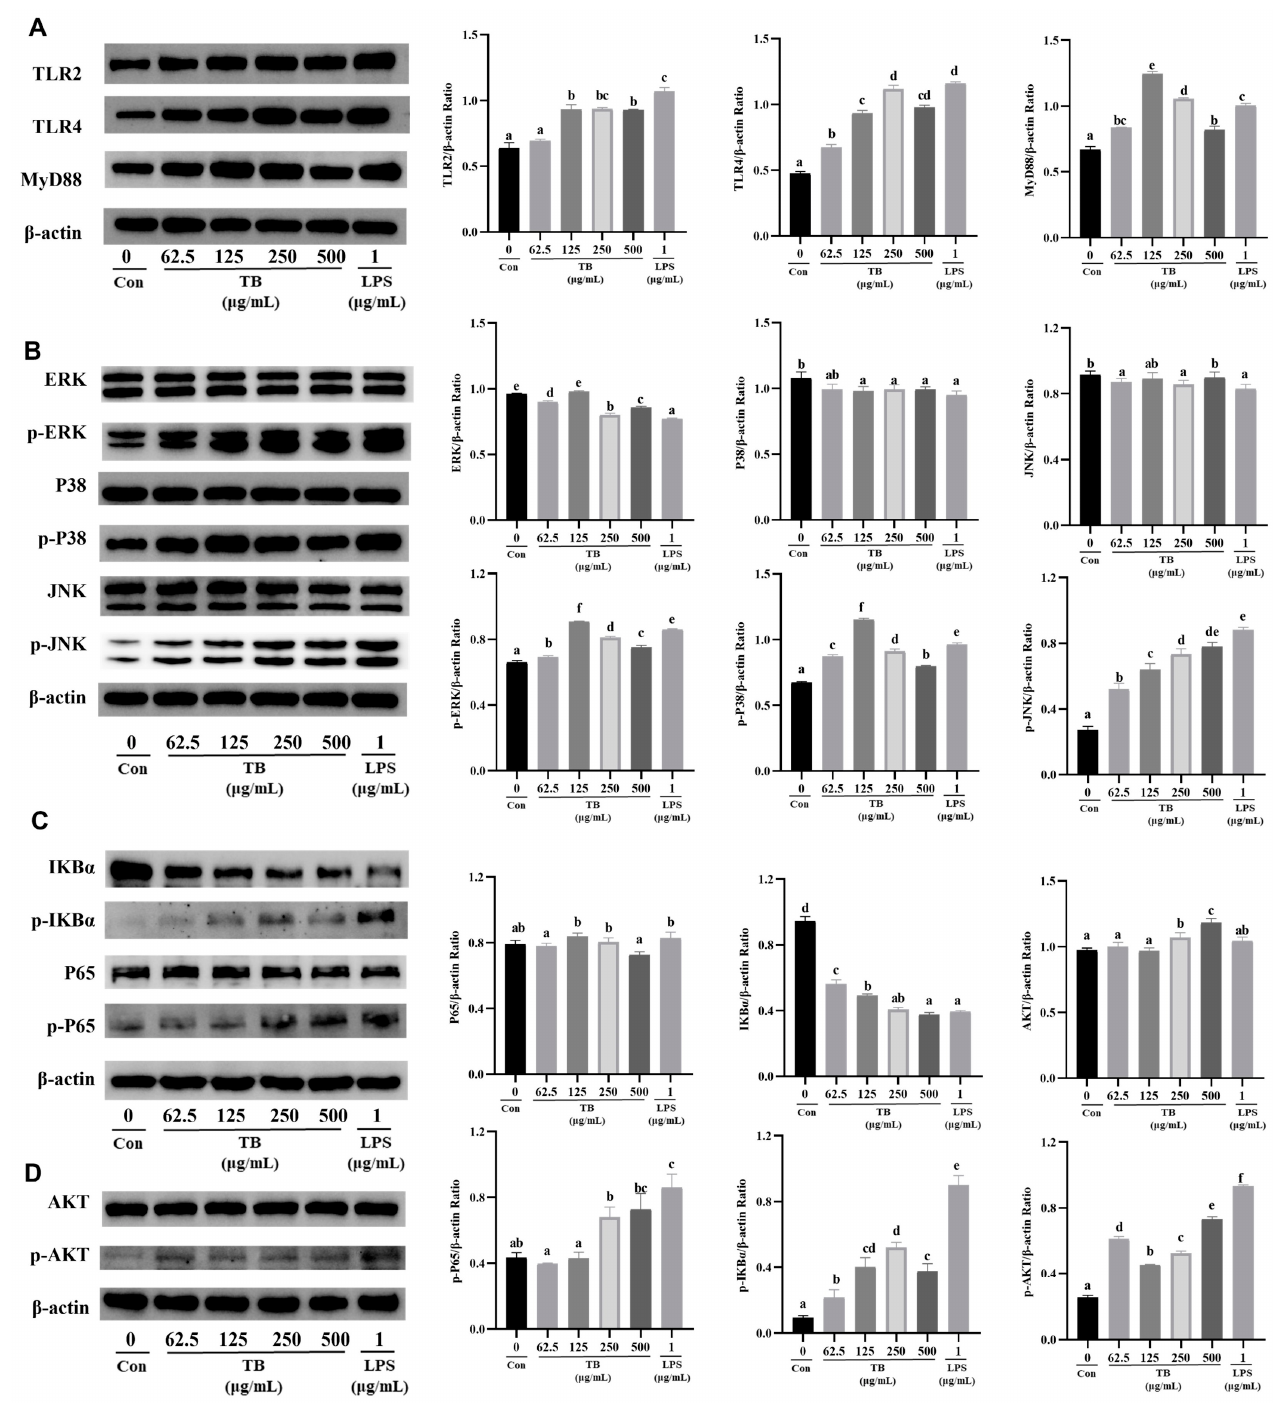
Figure 3. Western blot of immune enhancement effects of TB on TLR2/4-mediated pathway in RAW264.7 cells. ( A ) The expressions of TLR2/4 and MyD88. ( B ) The expressions of key proteins of the MAPK signaling pathway. ( C ) The expressions of key proteins of the NF- κ B signaling pathway. ( D ) The expression of AKT and p-AKT of the PI3K–AKT signaling pathway. β -actin was used as a loading control. The statistically significant differences are marked with different letters (a, b, c, d, e, f). The Western blot results suggest that TB treatment activates the TLR2/4-mediated MAPK/NF- κ B signaling pathway through the MyD88-dependent pathway and activates the PI3K–AKT signaling pathway via TLR2, enhancing the immune response of RAW264.7